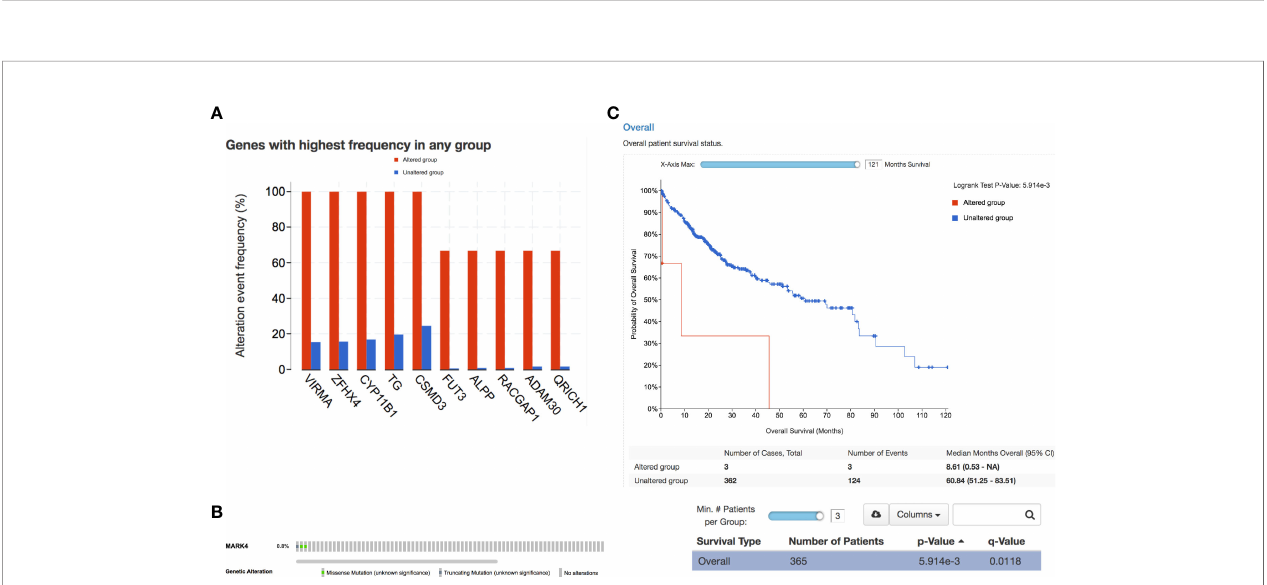
FIGURE 7 | Clinical relevance. (A) Overall highly mutated genes in the case of HCC. (B) Percentage of patients showing a mutation in MARK4 and (C) survival curve representing the signi fi cance of MARK4 in the HCC clinical